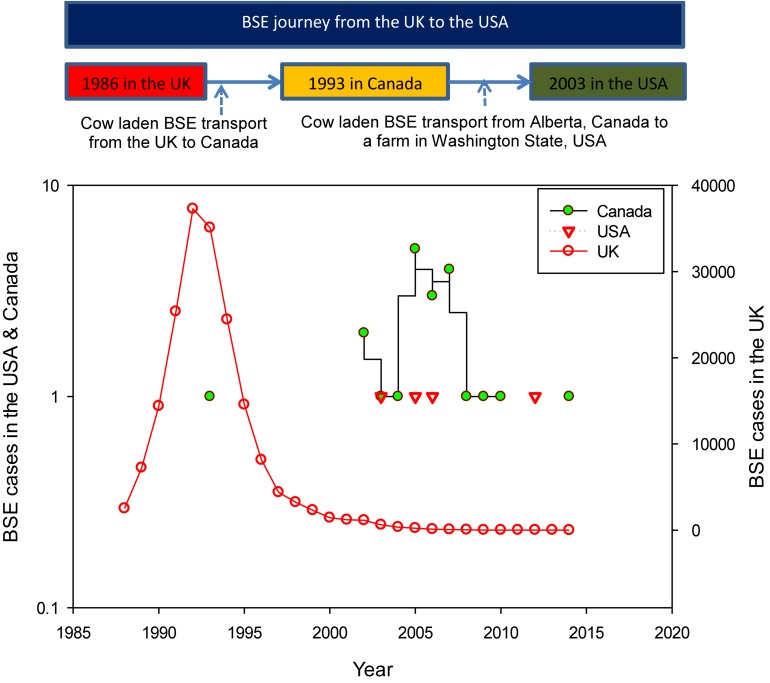
The BSE journey from the UK to the US via Canada (top), and the BSE cases in the UK, Canada, and the US (bottom) (data source of BSE cases: World Organization for Animal Health, 2015).